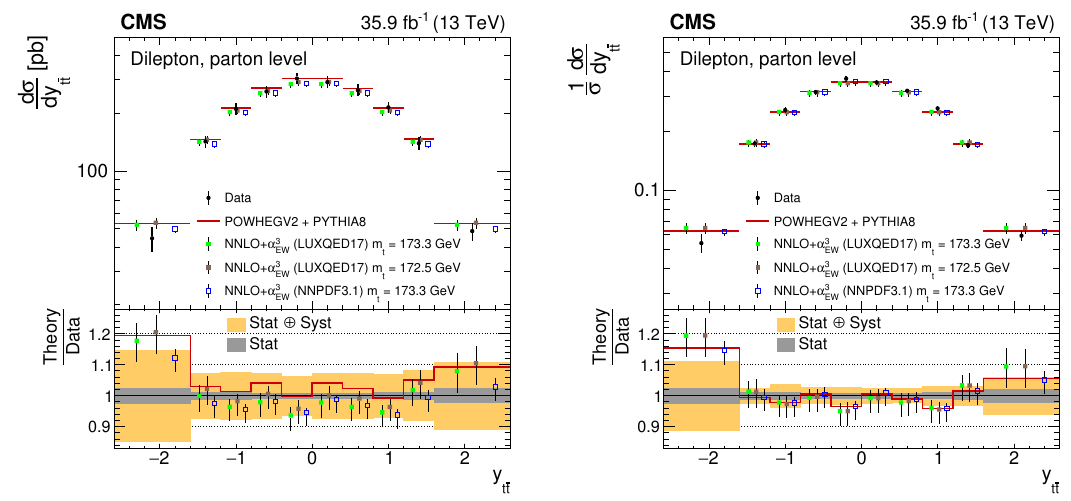
Figure 28 . The di(cid:11)erential tt production cross sections at the parton level in the full phase space as a function of y are shown for the data ((cid:12)lled circles), the theoretical predictions with beyond- tt NLO precision (other points) and the prediction from powheg + pythia (solid line). The vertical lines on the (cid:12)lled circles and other points indicate the total uncertainty in the data and theoretical predictions, respectively. The left and right plots correspond to absolute and normalised measure- ments, respectively. The lower panel in each plot shows the ratios of the theoretical predictions to the data. The dark and light bands show the relative statistical and total uncertainties in the data, respectively.